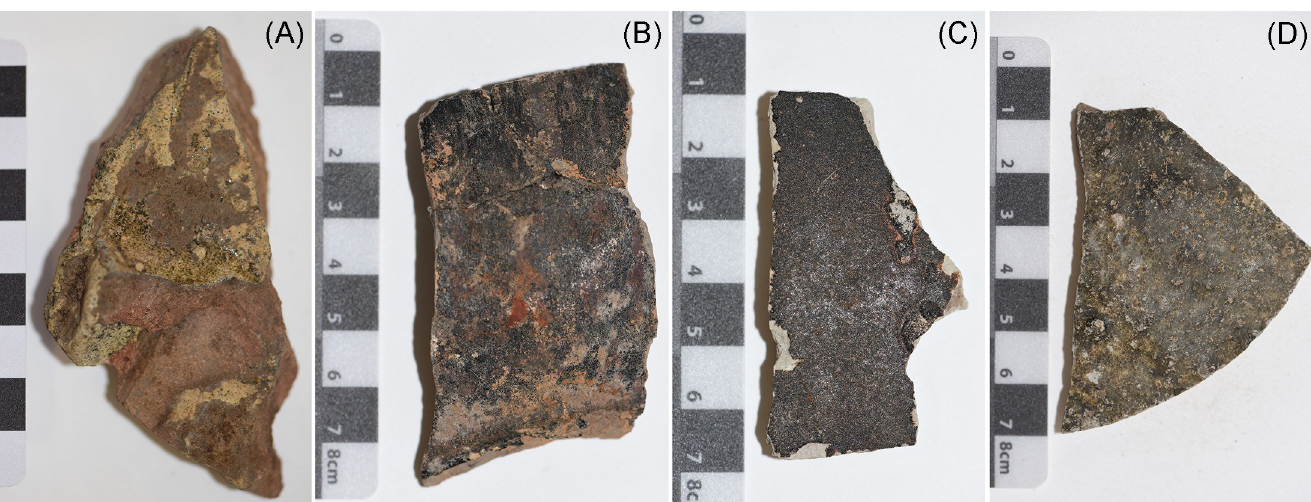
PLOS ONE | https://doi.org/10.1371/journal.pone.0216895 May 13,